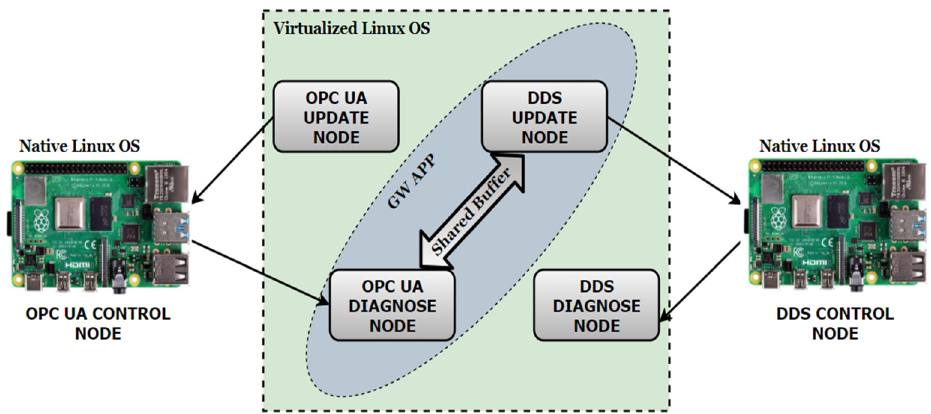
Figure 2. System Figure 2. System architecture.